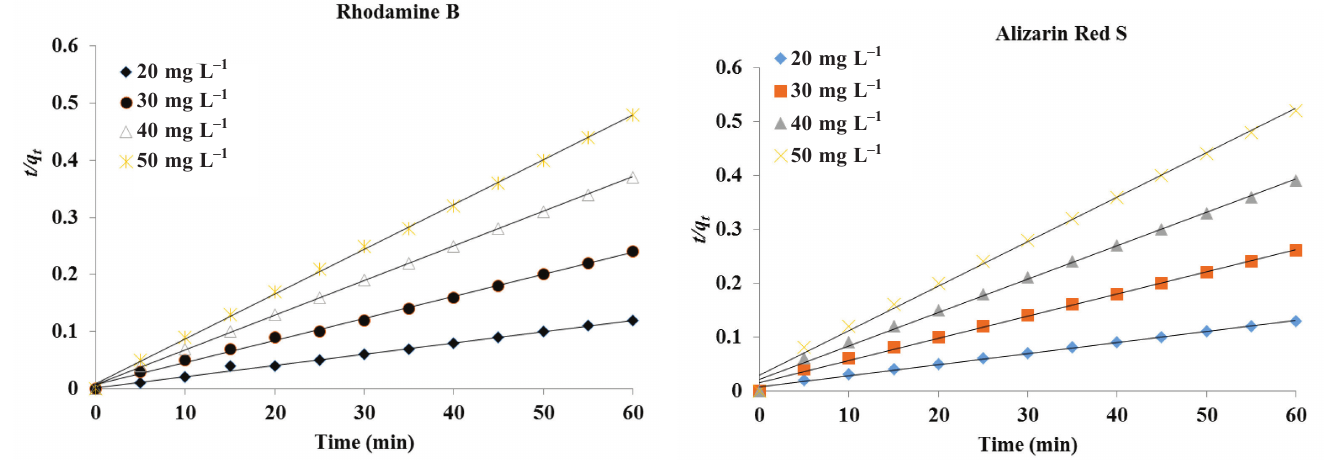
Fig. 10 – Plot of curves corresponding to equation of pseudo–second–order kinetics for the adsorption of Rhodamine B and Aliz­ arin Red S onto CES